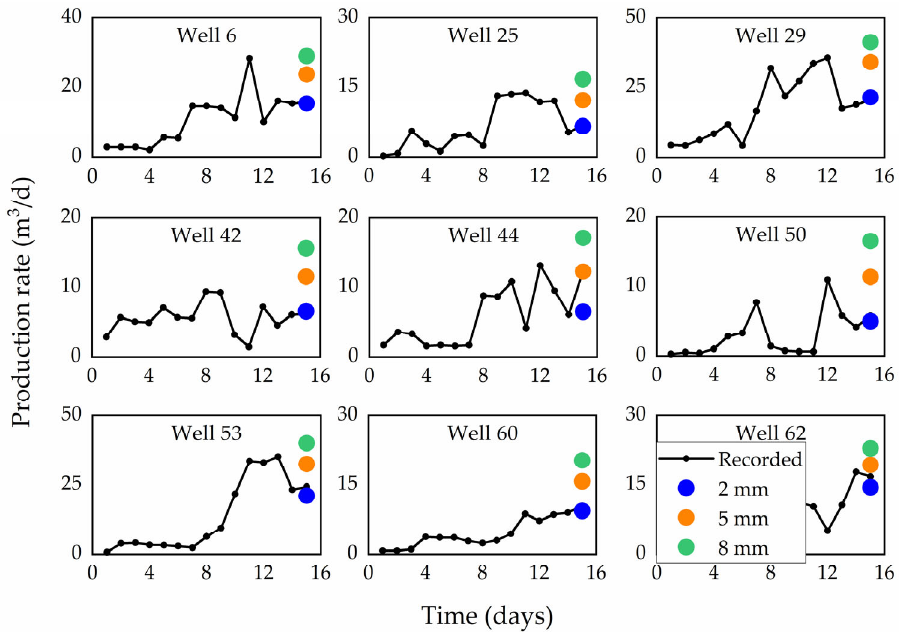
Figure 11. Effect of the CS on production rate.